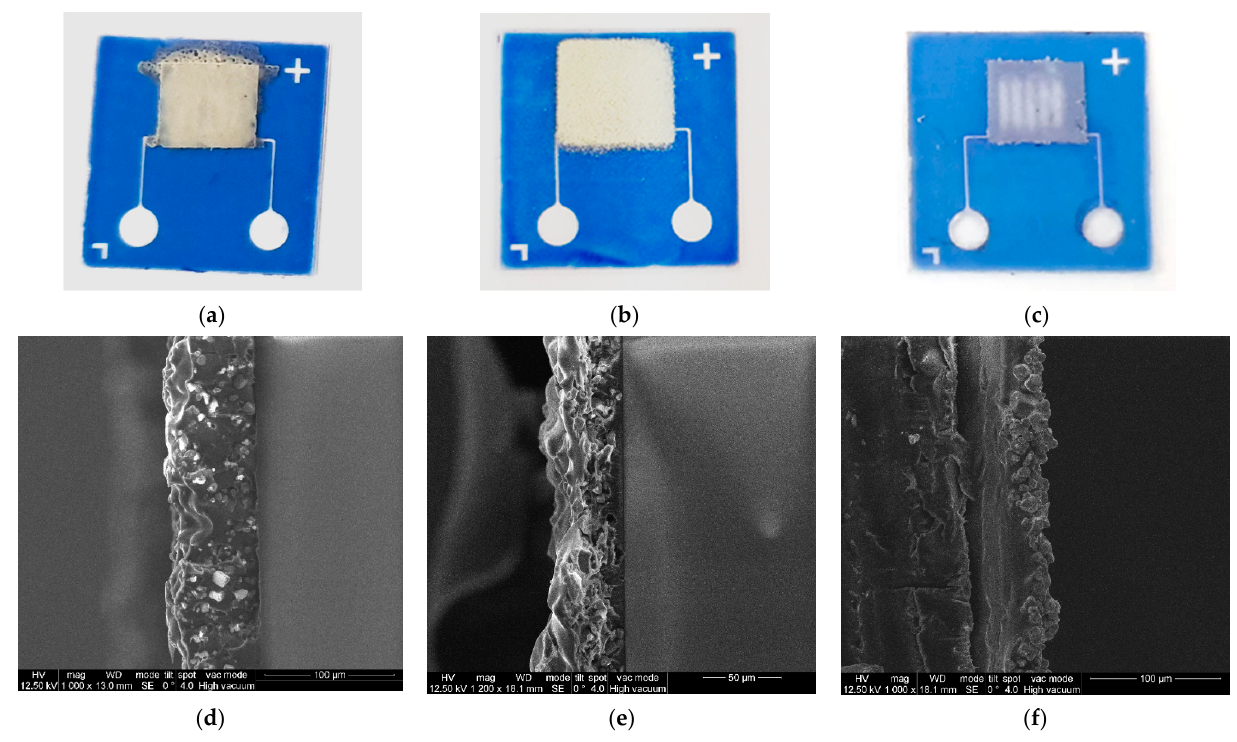
Figure 8. The microfluidic subsystem of the biosensor system with deposited luminophore layer by the following methods: ( a )—drip application from the liquid phase; ( b )—spraying from the liquid phase using airbrushing; ( c )—mechanical spraying on the adhesive surface; SEM images of cross-sections of glass substrates with a luminophore layer; ( d )—drip application from the liquid phase; ( e )—spraying from the liquid phase using airbrushing; ( f )—mechanical spraying on the adhesive surface.